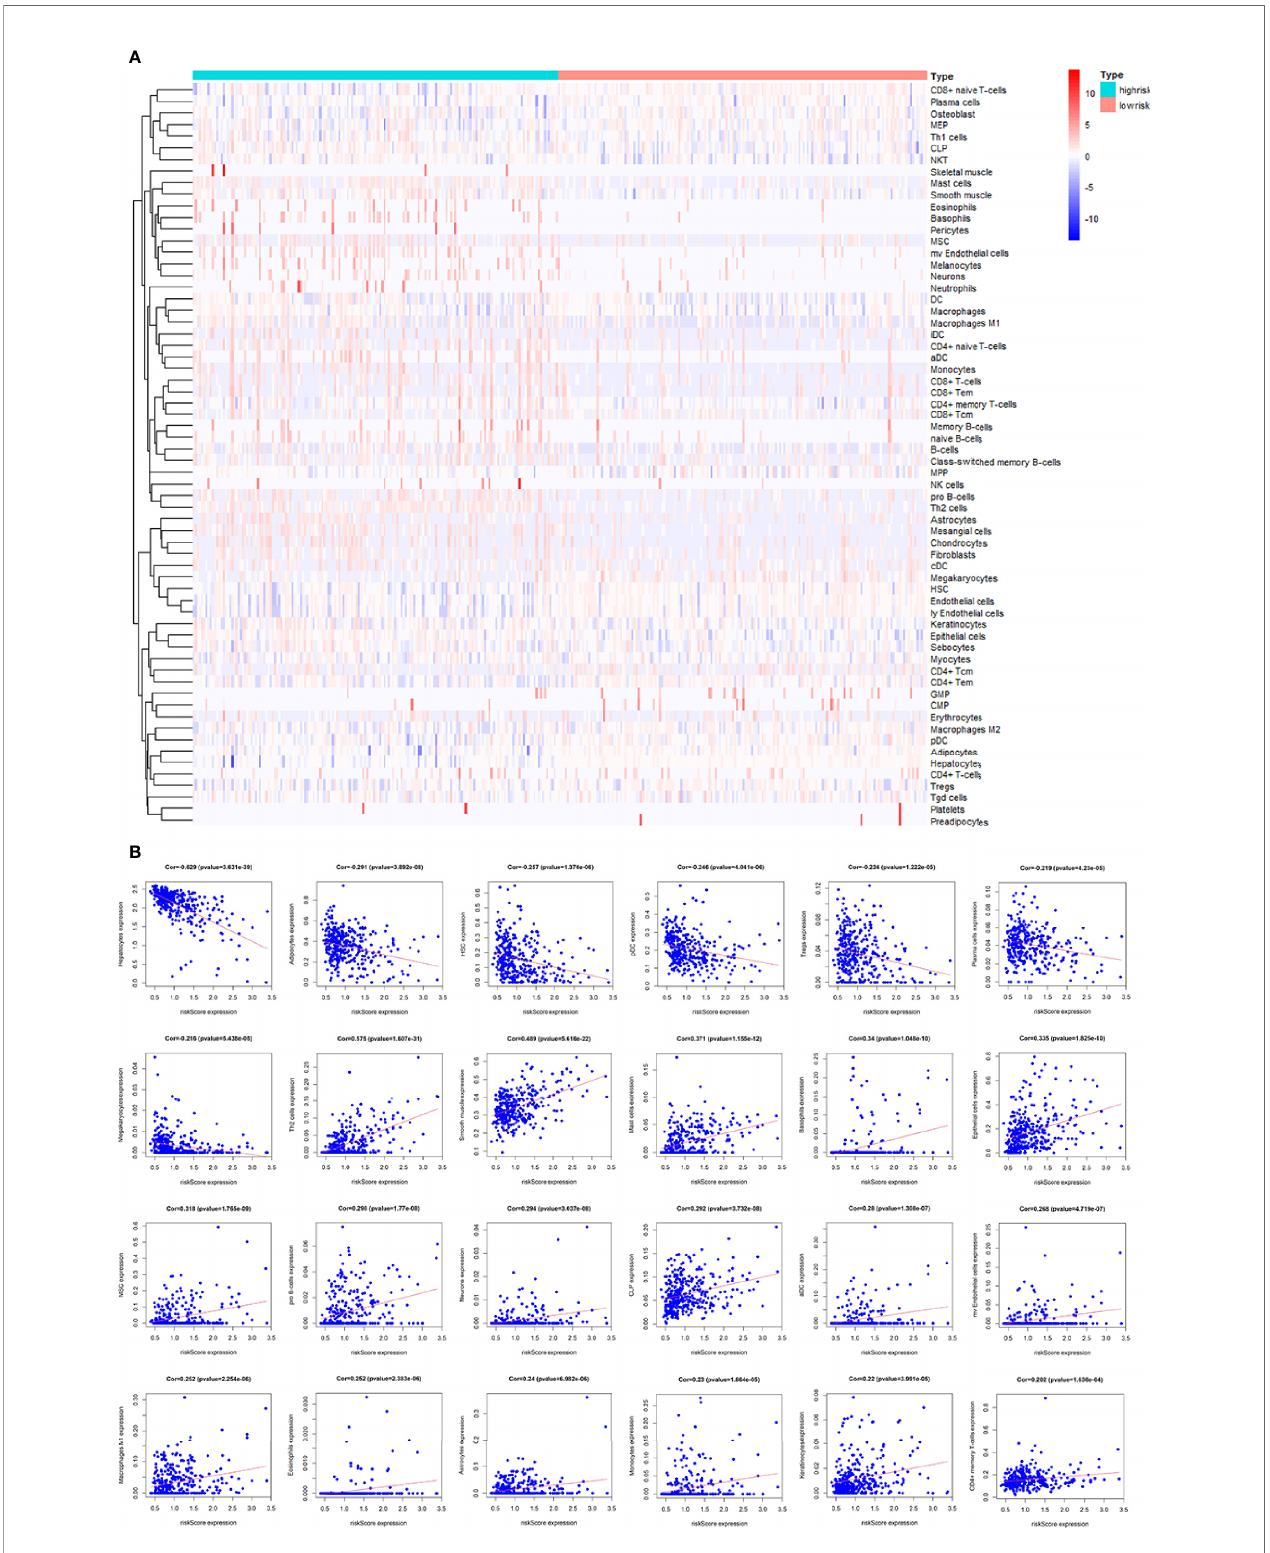
FIGURE 7 | Correlation between the immune-related lncRNA signature and 64 cell heterogeneity using xCell. (A) The heatmap showed the 64 cells abundance in high-risk groups and low-risk groups. (B) Correlation between cell heterogeneity and this immune-related lncRNA